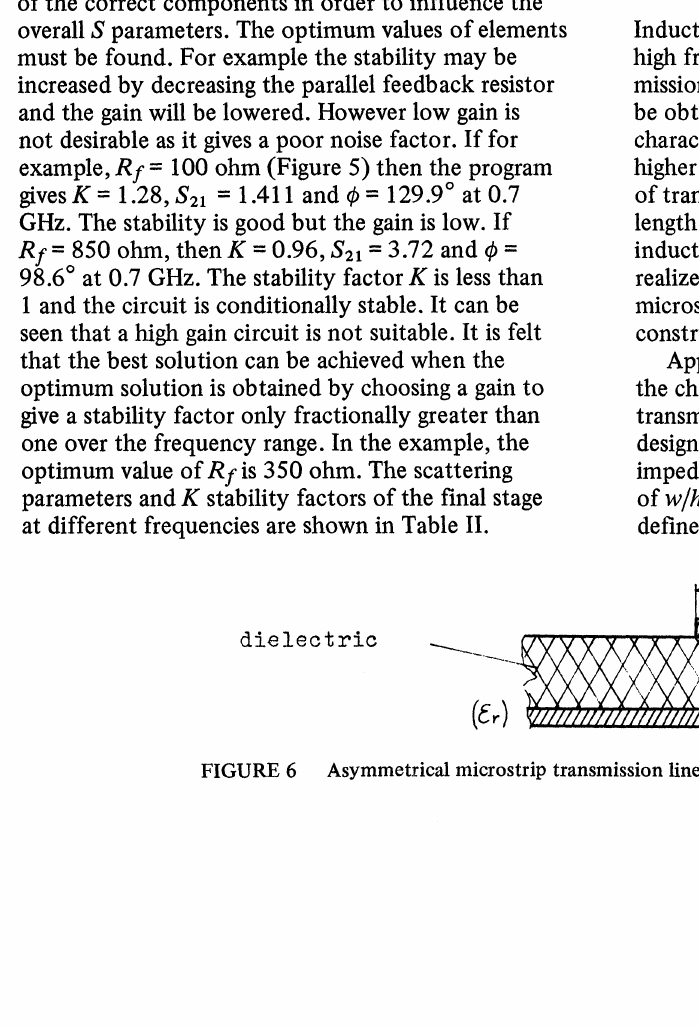
FIGURE 6 Asymmetrical microstrip transmission line. er relative dielectric